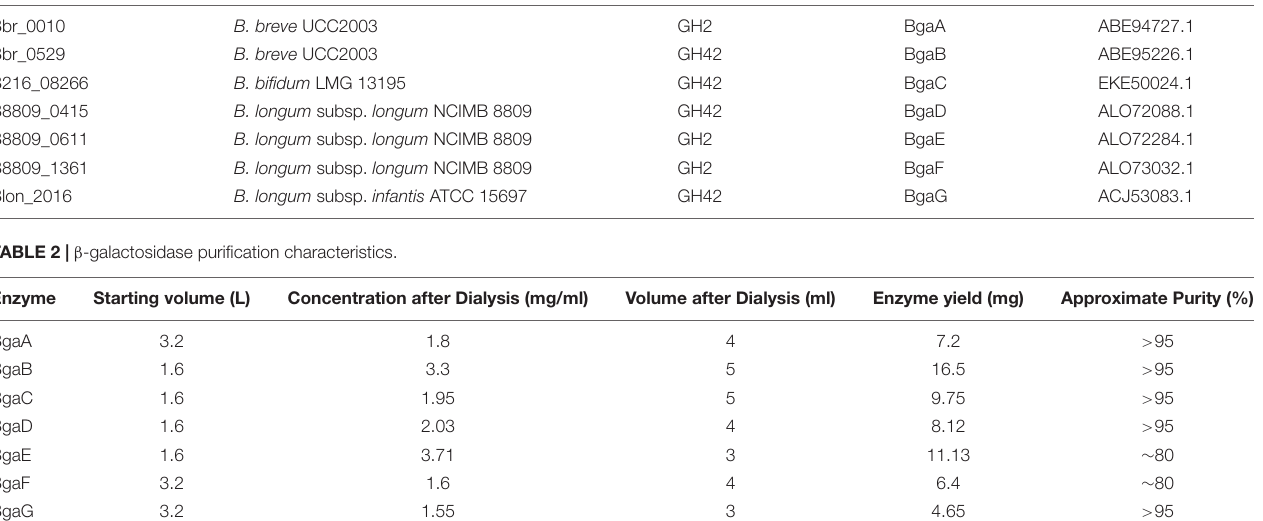
TABLE 1 | Description of the enzymes employed. Locus tag Origin